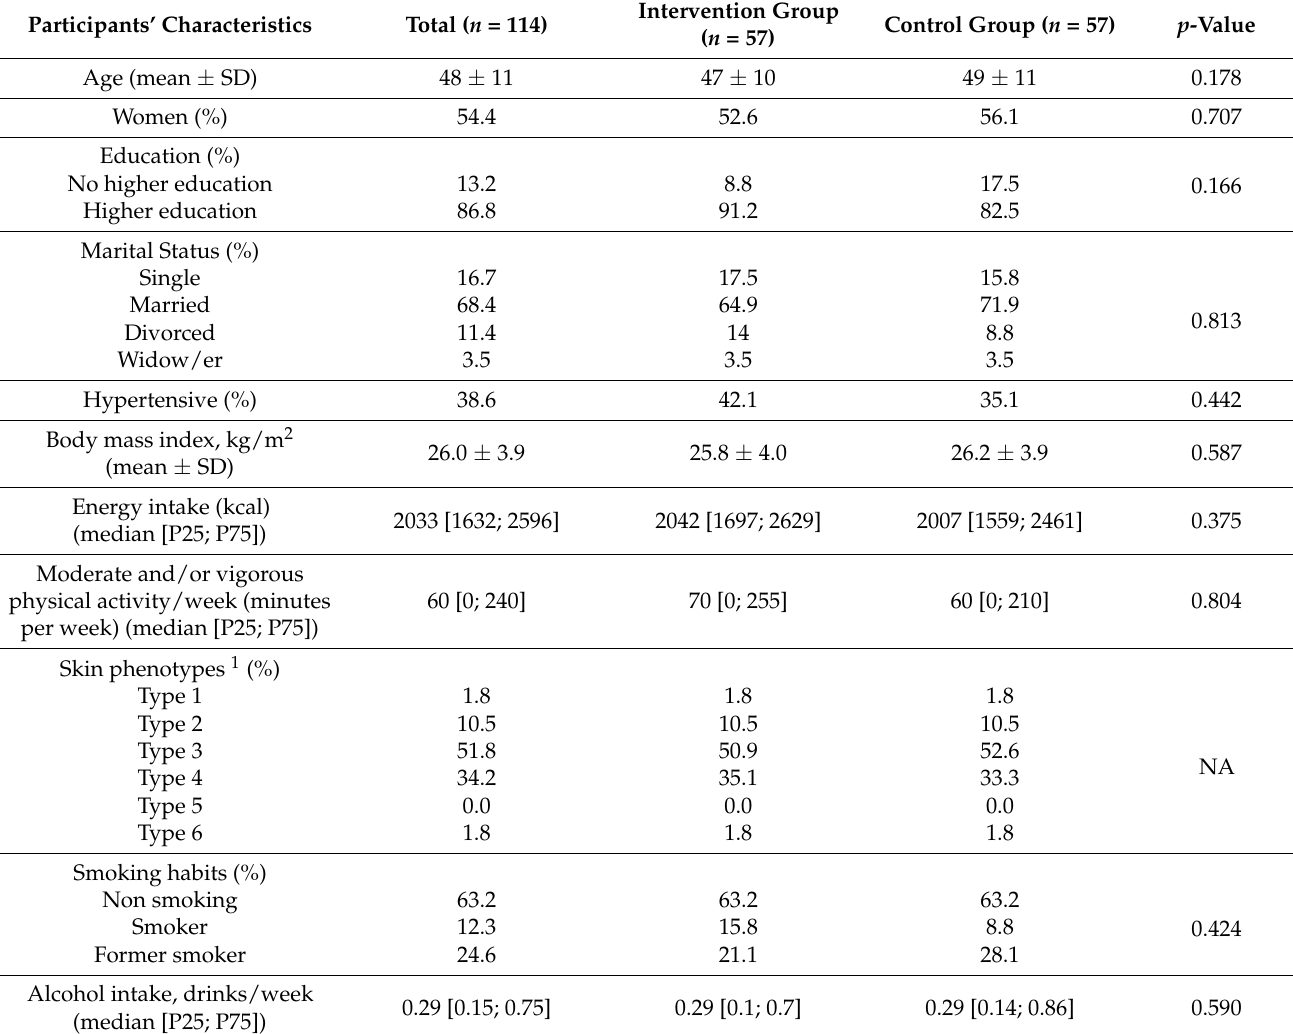
Table 1. Sociodemographic, lifestyle, clinical, anthropometric, and nutritional characteristics of 114 adults participating in a randomized control trial.